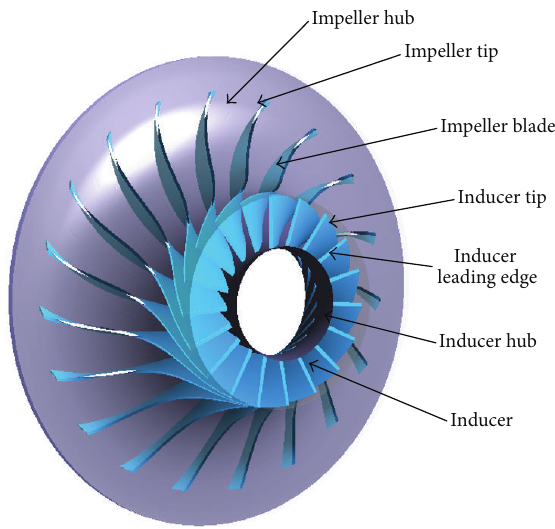
Figure 1: CAD model of centrifugal compressor impeller with shroud removed.